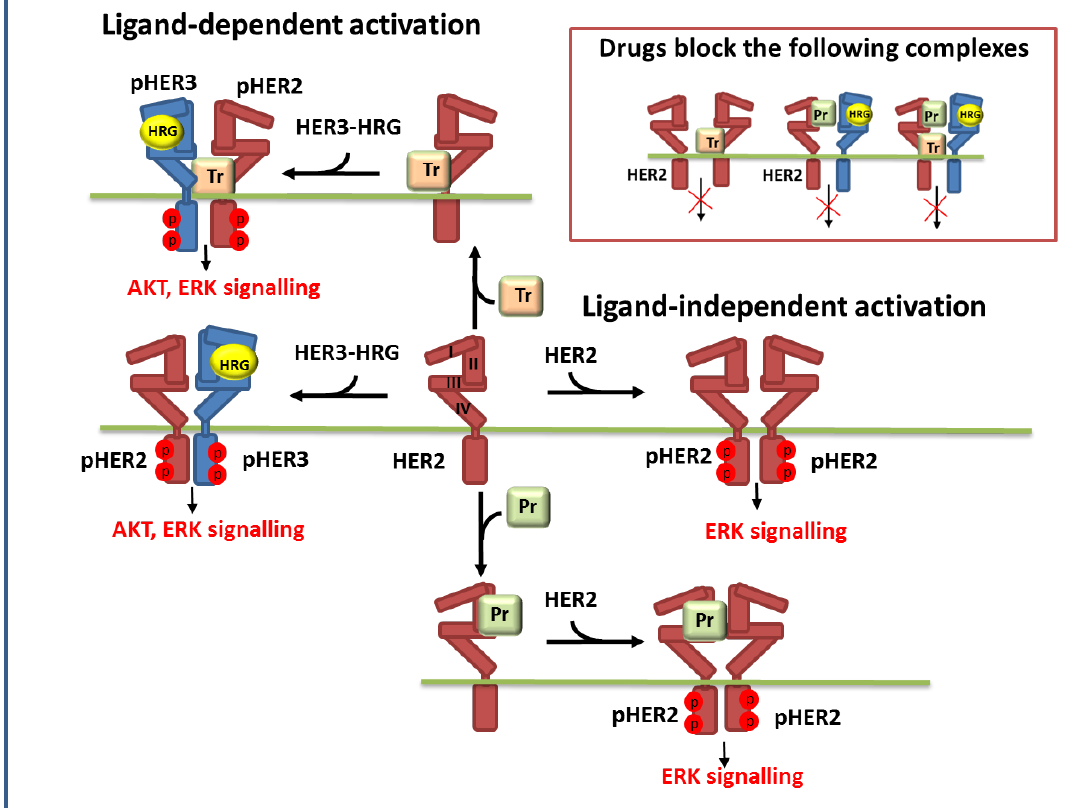
Figure 1. Schematic representation of the reactions of ligand-independent and ligand-dependent homo- and heterodimerisation of HER2 and HER3 receptors in the presence of HER3 ligand (HRG) and anti-HER2 drugs: trastuzumab (Tr) and pertuzumab (Pr). Inset in the upper right corner depicts the dimer complexes of HER2 and HER3 which are blocked by these